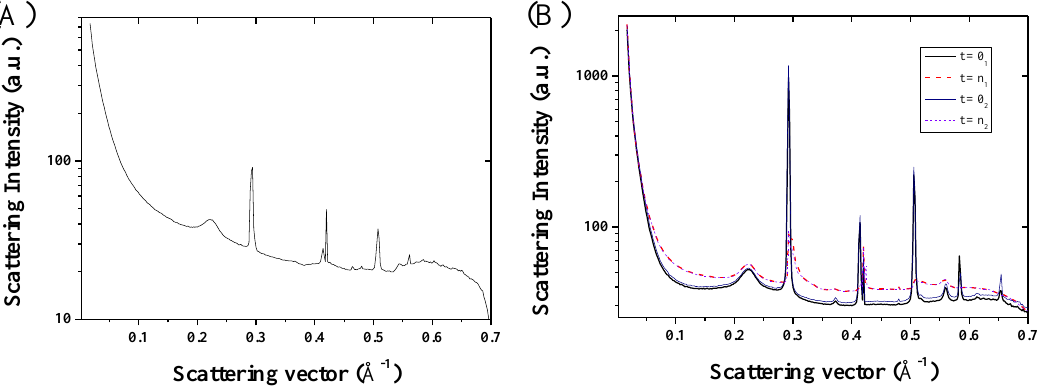
Figure A4. ( A ) Typical SAXS pattern for a ZiF-8@CNT membrane in air at 1 atm feed and permeate pressure; ( B ) Examples of permeation and peak recovery across the ZiF8@CNT membranes for He permeation corresponding respectively to t = 0 1 , the first duty cycle of pressurization, t = n 1 , the end of the first cycle, t = 0 2 , corresponding to the start of the second cycle, and t = n 2 , the end of the 2nd cycle.